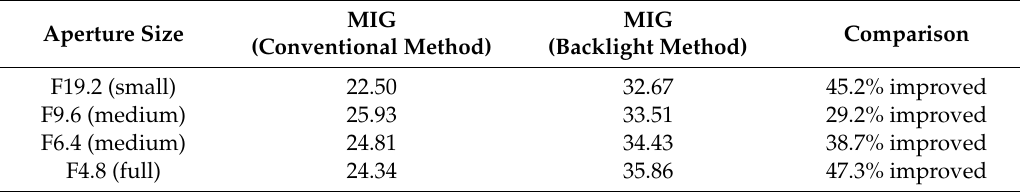
Table 2. Mean intensity gradient (MIG) of two speckles with di ff erent aperture